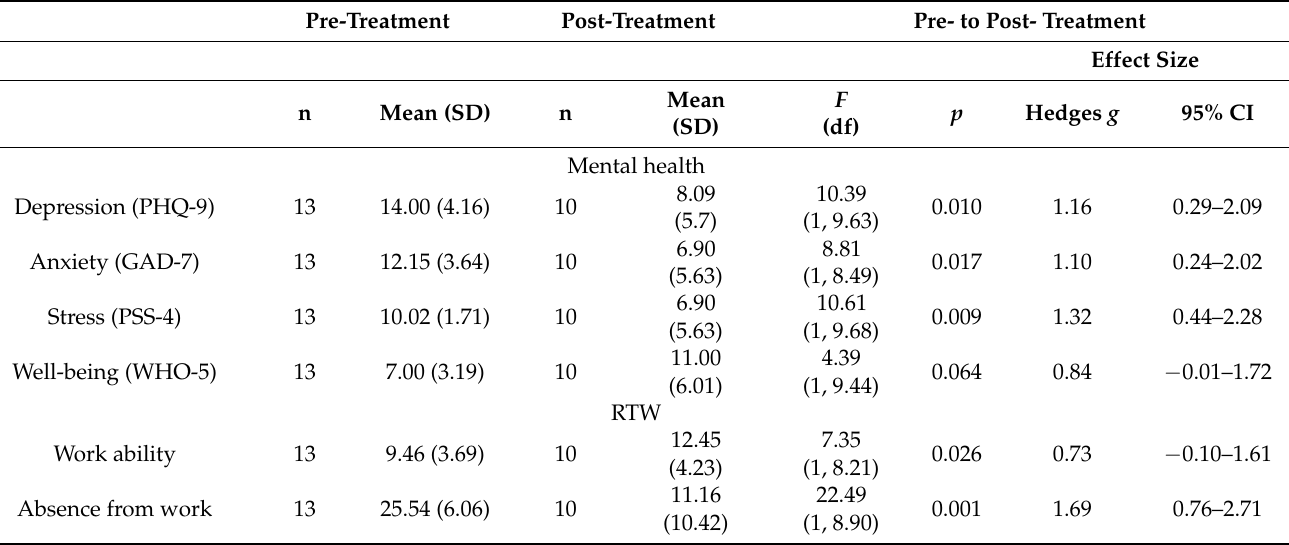
Table 4. Estimated marginal means at pre-treatment and post-treatment following Workable